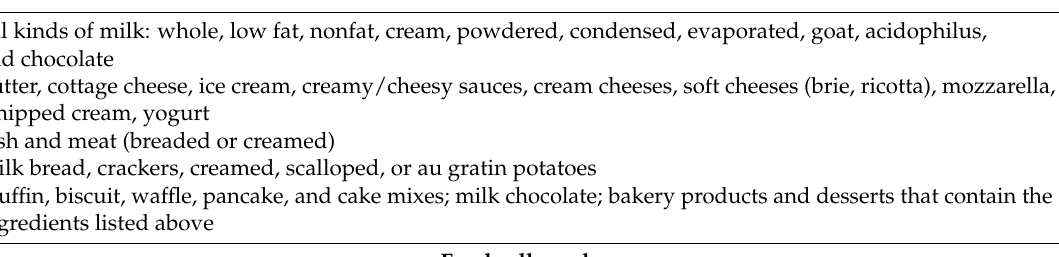
Table 4. Low lactose diet. Foods to